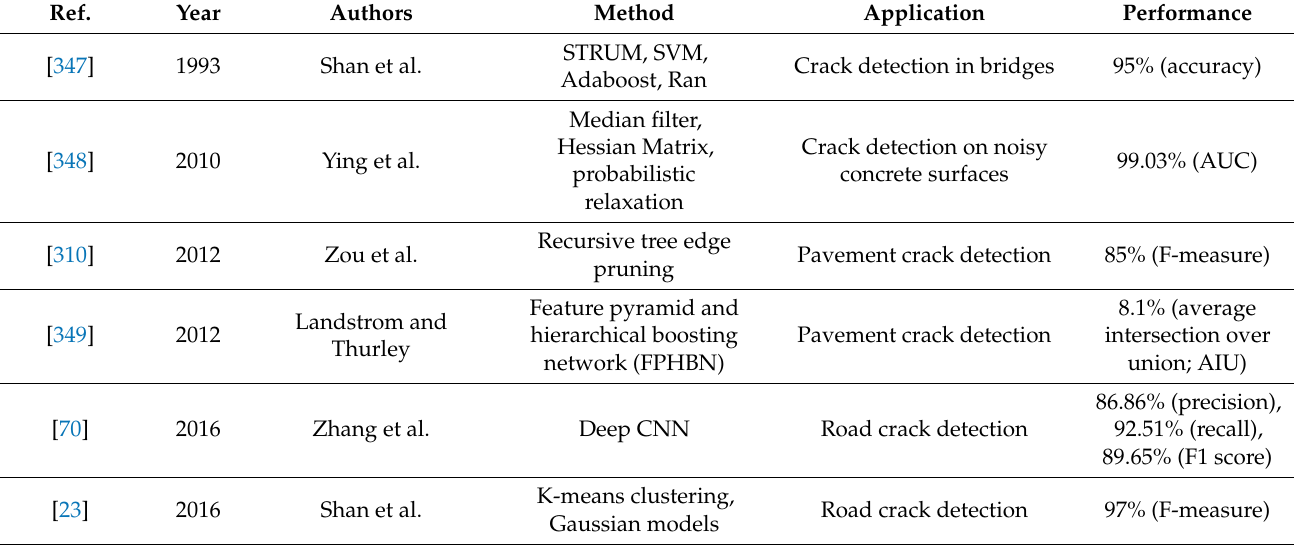
Table 10. Structural Damage Detection Studies with CV